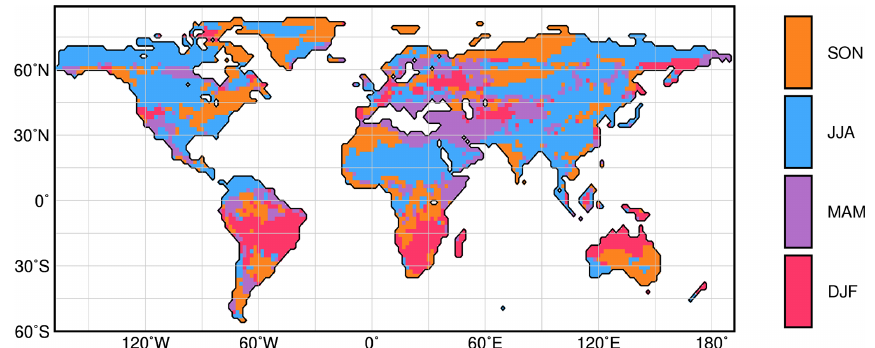
Figure 5. Season which contributes most to the annual mean precipitation change between 8 and 2.15ka in the model, i.e. September to November (SON), June to August (JJA), March to May (MAM) and December to February (DJF). Please note that the seasons are calculated on the fixed model calendar and are not adjusted to the astronomical forcing (cf. Bartlein and Shafer, 2019).